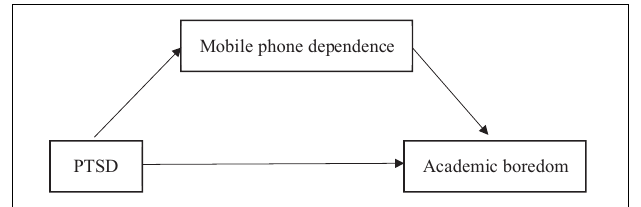
FIGURE 1 | The hypothesized mediating effect